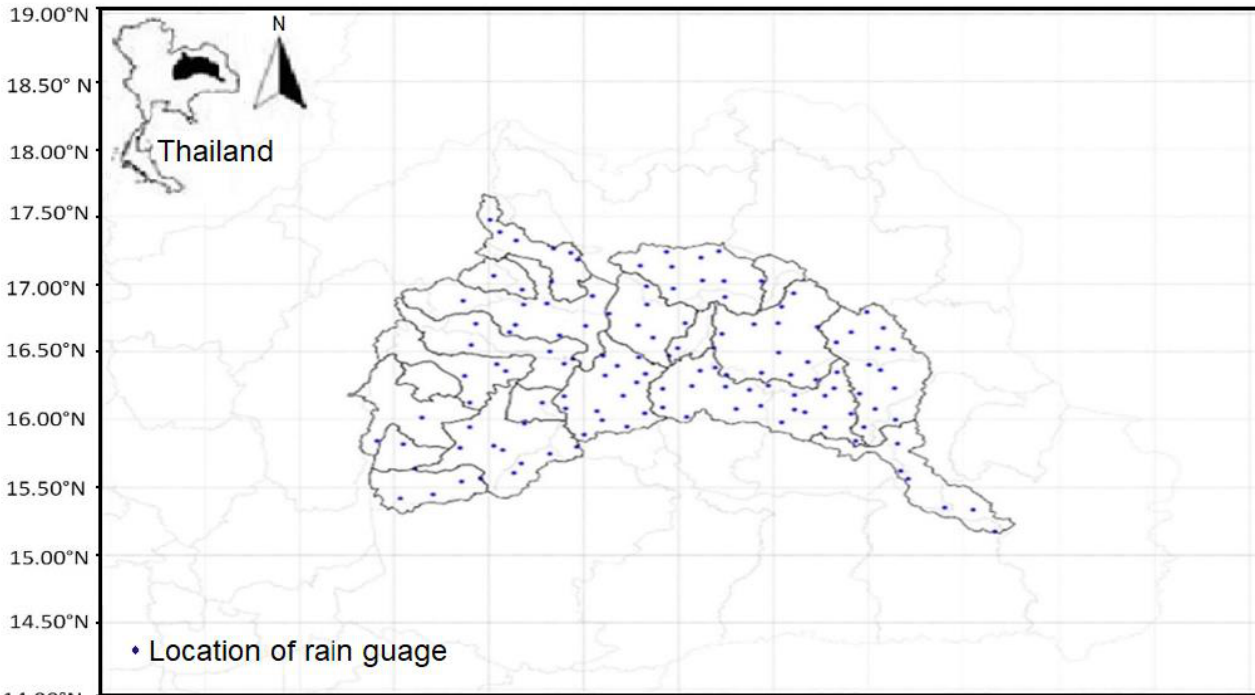
Figure 3. Location of 129 rain gauge stations in the Chi Basin study area.